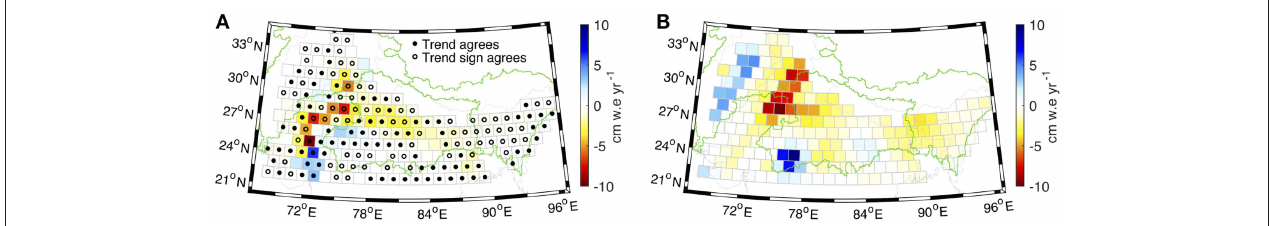
FIGURE 4 | Comparison between mass trends for (A) groundwater data and (B) GRACE L1B regression mascons. The open circles in (A) indicate where the sign of the groundwater trend agrees with the 99% confidence interval and the closed circles indicate where the groundwater trend estimate is within the 99% confidence interval. Trends are computed for January 2003–July